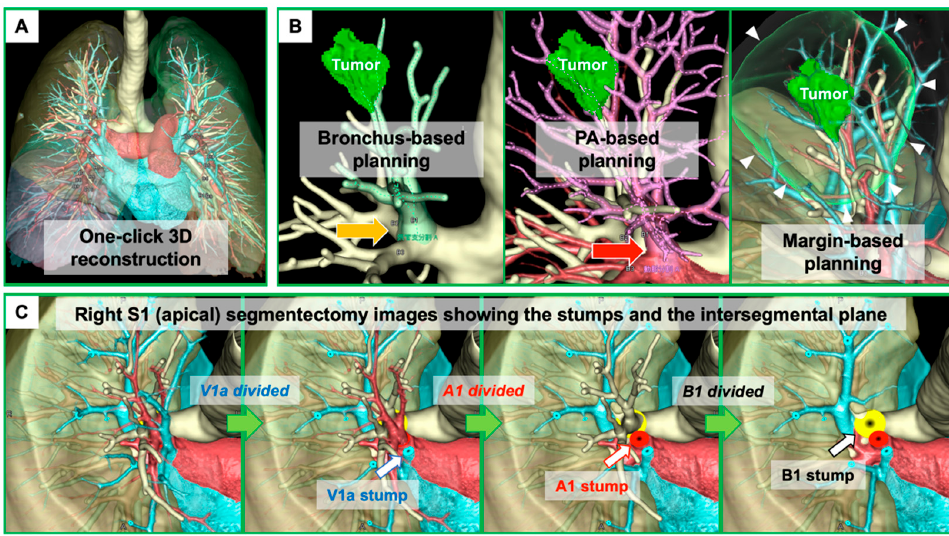
Figure 1. Three-dimensional computed tomography (3DCT) images in segmentectomy planning us- ing a novel 3DCT processing software (REVORAS, Ziosoft, Inc., Tokyo, Japan). ( A ) Three-dimensional (3D) reconstruction can be obtained by the surgeon with “one click” to select a series of CT scans with or without contrast. ( B ) There are various types of segmentectomy planning, including bronchus-based, pulmonary artery (PA)-based, and margin-based. Yellow arrow: level of division of the target bronchus. Red arrow: level of division of the target PA. White arrowheads; two-centimeter margin from the tumor. ( C ) Simulation images, including the bronchial and vascular stumps and the intersegmental plane.